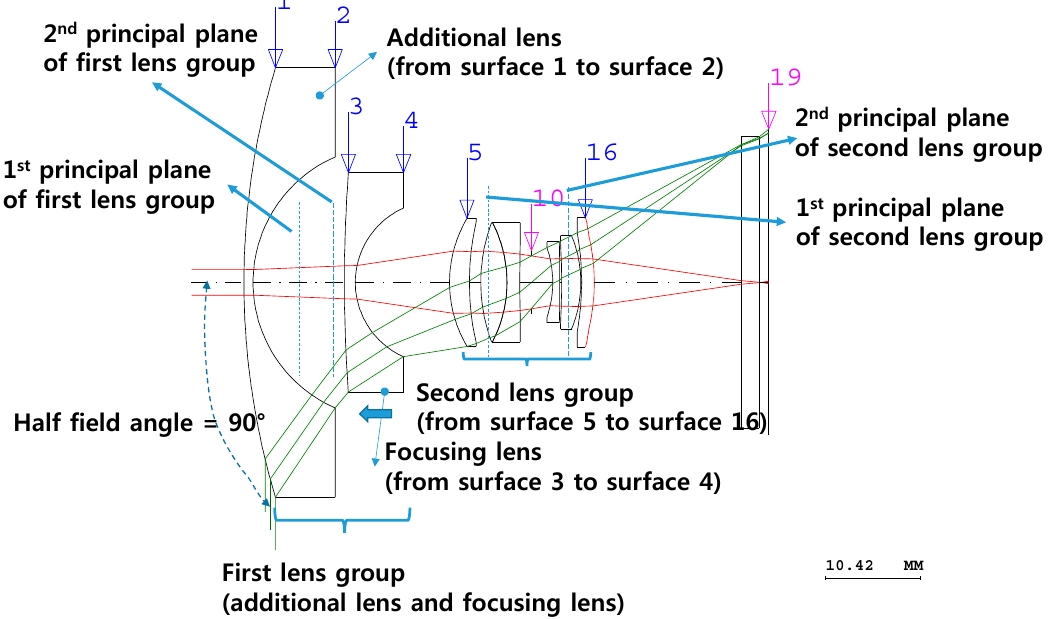
Figure 2. Optical layout of the designed fisheye lens for the paraxial design.